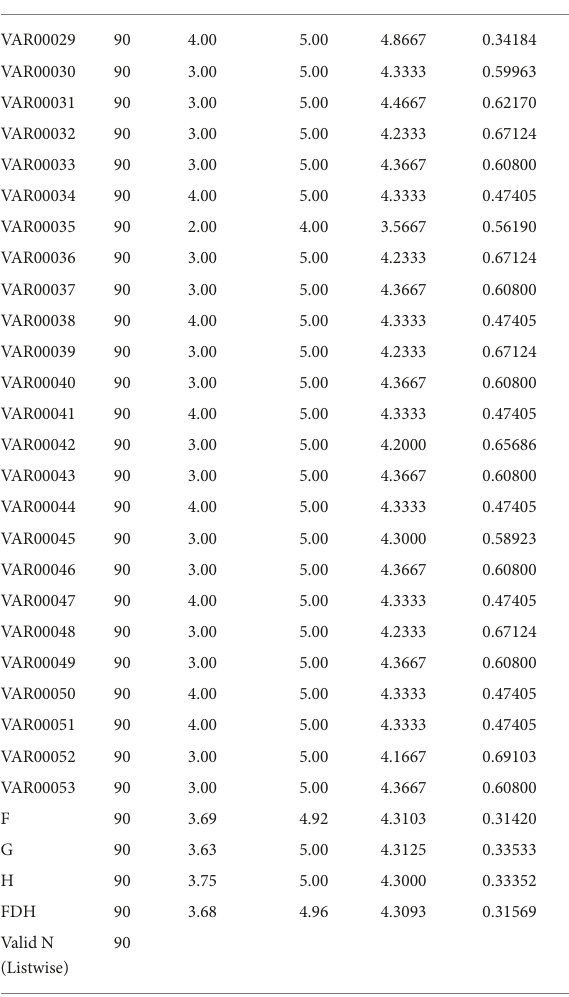
TABLE 3 Descriptive statistics for